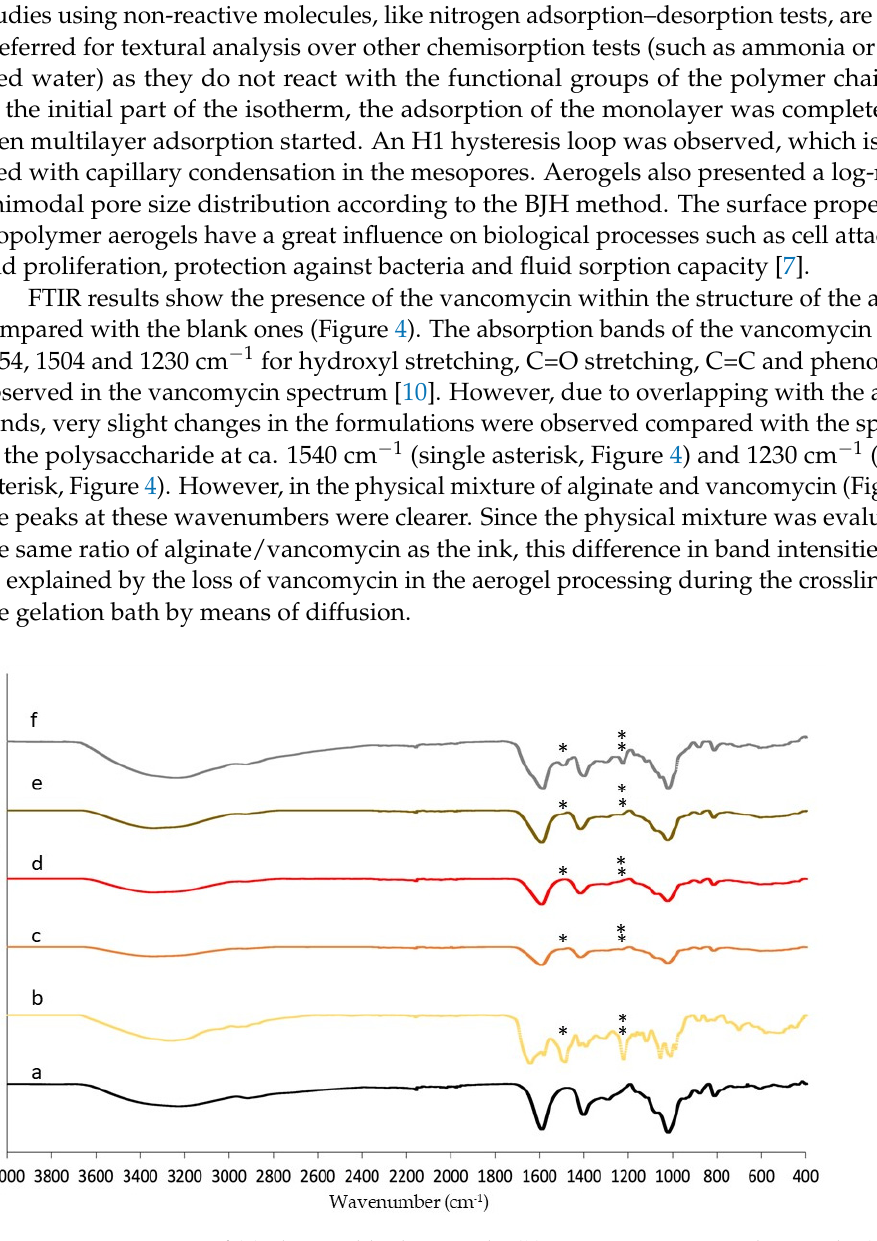
Figure 4. FTIR spectra of ( a ) alginate blank aerogels; ( b ) vancomycin; printed aerogels; ( c ) type I: 0.75% alginate in the ink and a saturated bath of vancomycin in CaCl 2 O.8 M; ( d ) type II: 0.75% alginate and 17% ( w/w alginate) vancomycin forming part of the ink; ( e ) type III: drug both in the saturated vancomycin aqueous bath and forming part of the ink and ( f ) the physical mixture of alginate and vancomycin powders. Single asterisk and double asterisks indicate the presence in all formulations of typical bands of vancomycin at 1540 cm − 1 and 1230 cm − 1 respectively.